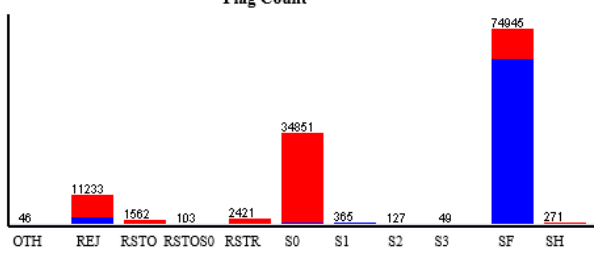
Figure 6. Analysis between service and flag.